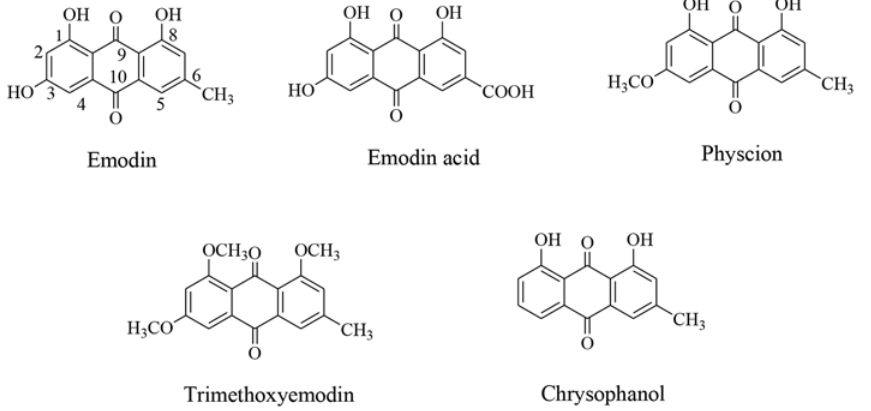
Fig 1. Chemical structures of emodin